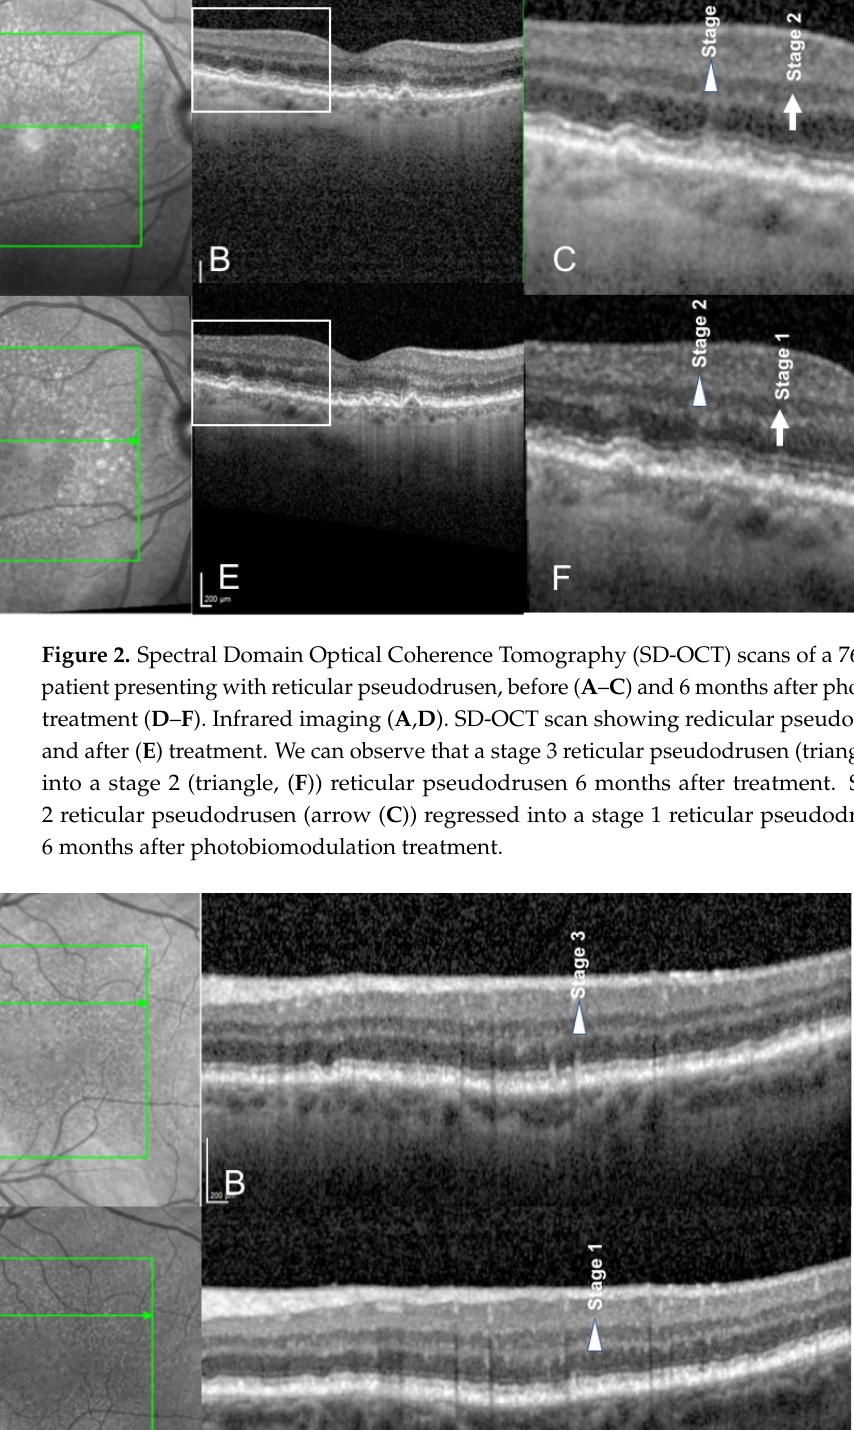
treatment. The number of stage 3 reticular pseudodrusen decreased while stage 1 reticular pseudo- drusen increased after treatment.